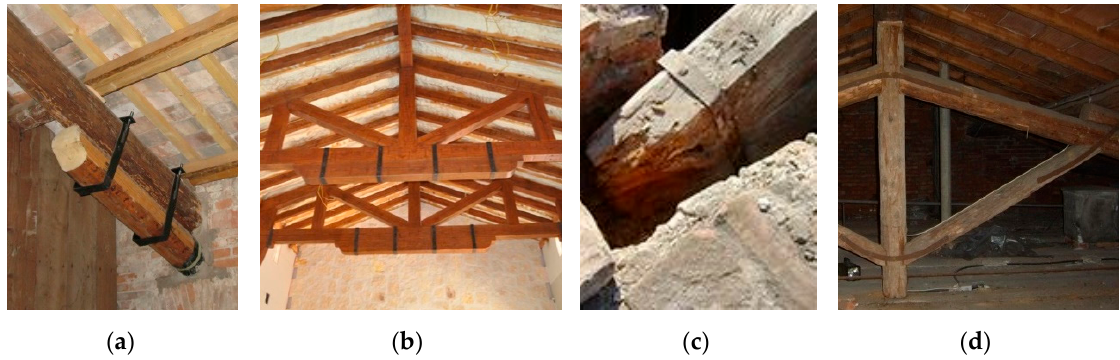
Figure 10. The traditional use of metal fasteners in critical sections of the timber beam floor and the king post roof truss: ( a ) timber template-beam (beam-floor); ( b ) joint king post-tie beam (truss); ( c ) joint strut-king post and principal rafter-king post (truss); ( d ) joint principal rafter-tie beam (truss).